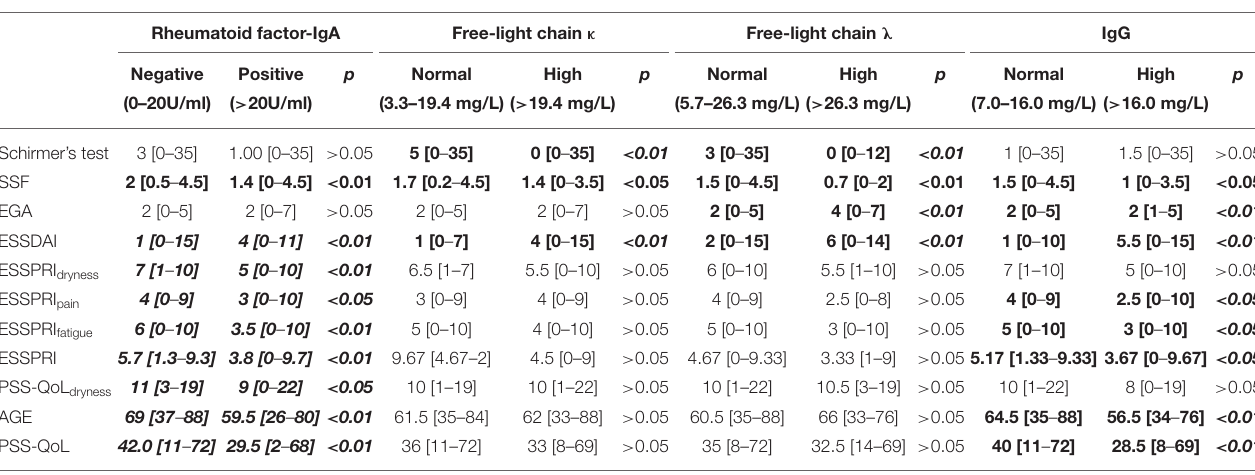
TABLE 3 | Differences of clinical parameters in immunological groups. Rheumatoid factor-IgA Free-light chain κ Free-light chain λ IgG Negative Positive p Normal High p Normal High p Normal High